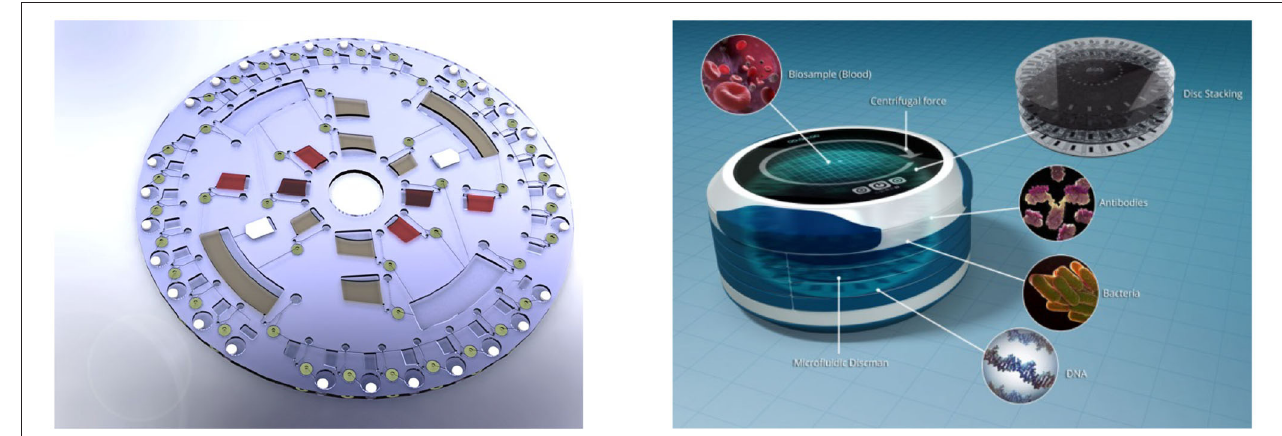
FIGURE 1 | Lab-on-a-Disc (LoaD) systems feature a modular setup of a single-use, polymer chip, often of similar geometry as common optical storage media like CD, DVD, or Blu-ray, which features a network of chambers for batch-wise conditioning of (bio-)samples and reagents. These chambers represent Laboratory Units Operations (LUOs) such as metering, mixing, aliquoting, purification, concentration, and particle separation, which are sequentially processed in a batch-wise fashion along a conventional laboratory protocol through normally closed valves placed at their interconnecting